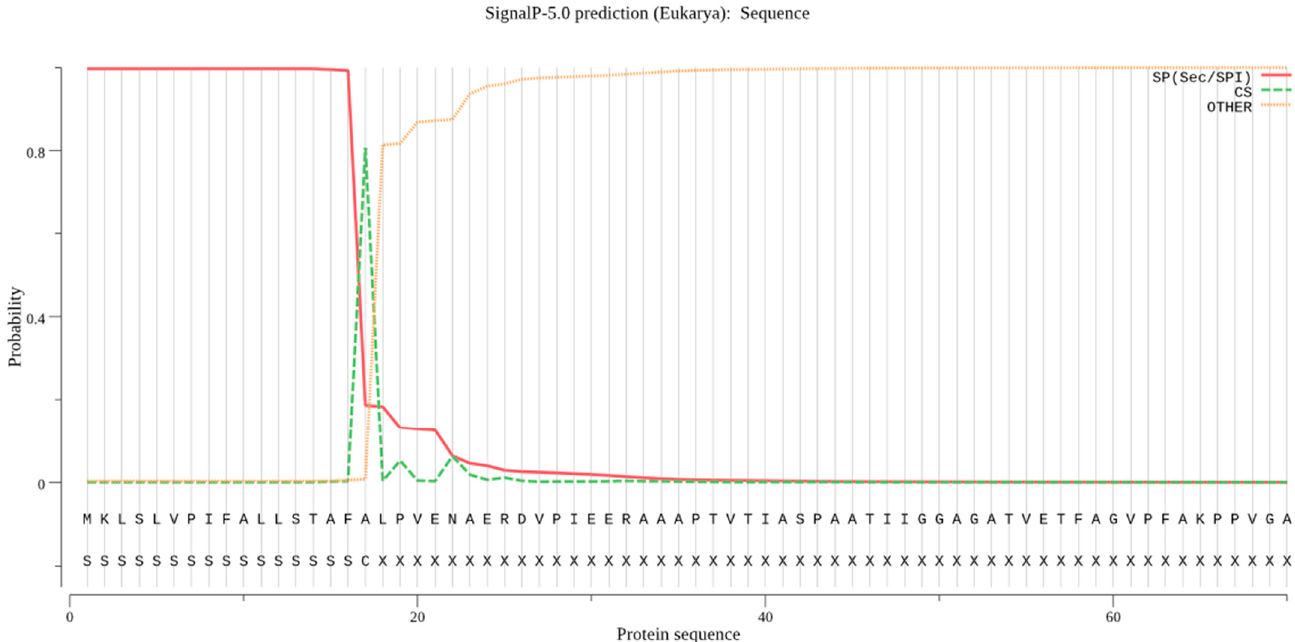
Figure 3. Signal peptides of B. cinerea lipase are presented by using SignalP server. Signal peptides are present in B. cinerea protein that direct it to the subcellular localization site. The signal peptide is 27 aa residues long in the lipase protein sequence.